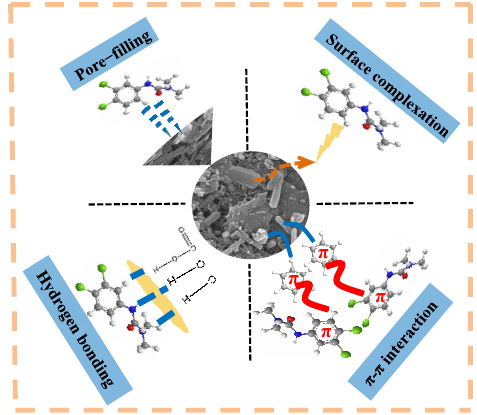
Figure 6. Schematic diagram of the adsorption mechanism of biochar to diuron.